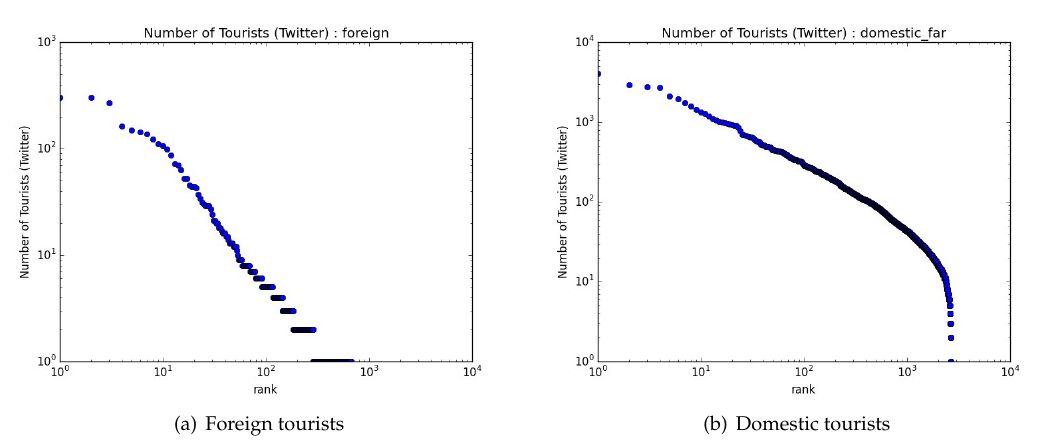
Figure 6. Distributions of the numbers of tourists: Both distributions follow a power law, but the slope for foreign tourists is steeper than that for domestic tourists.